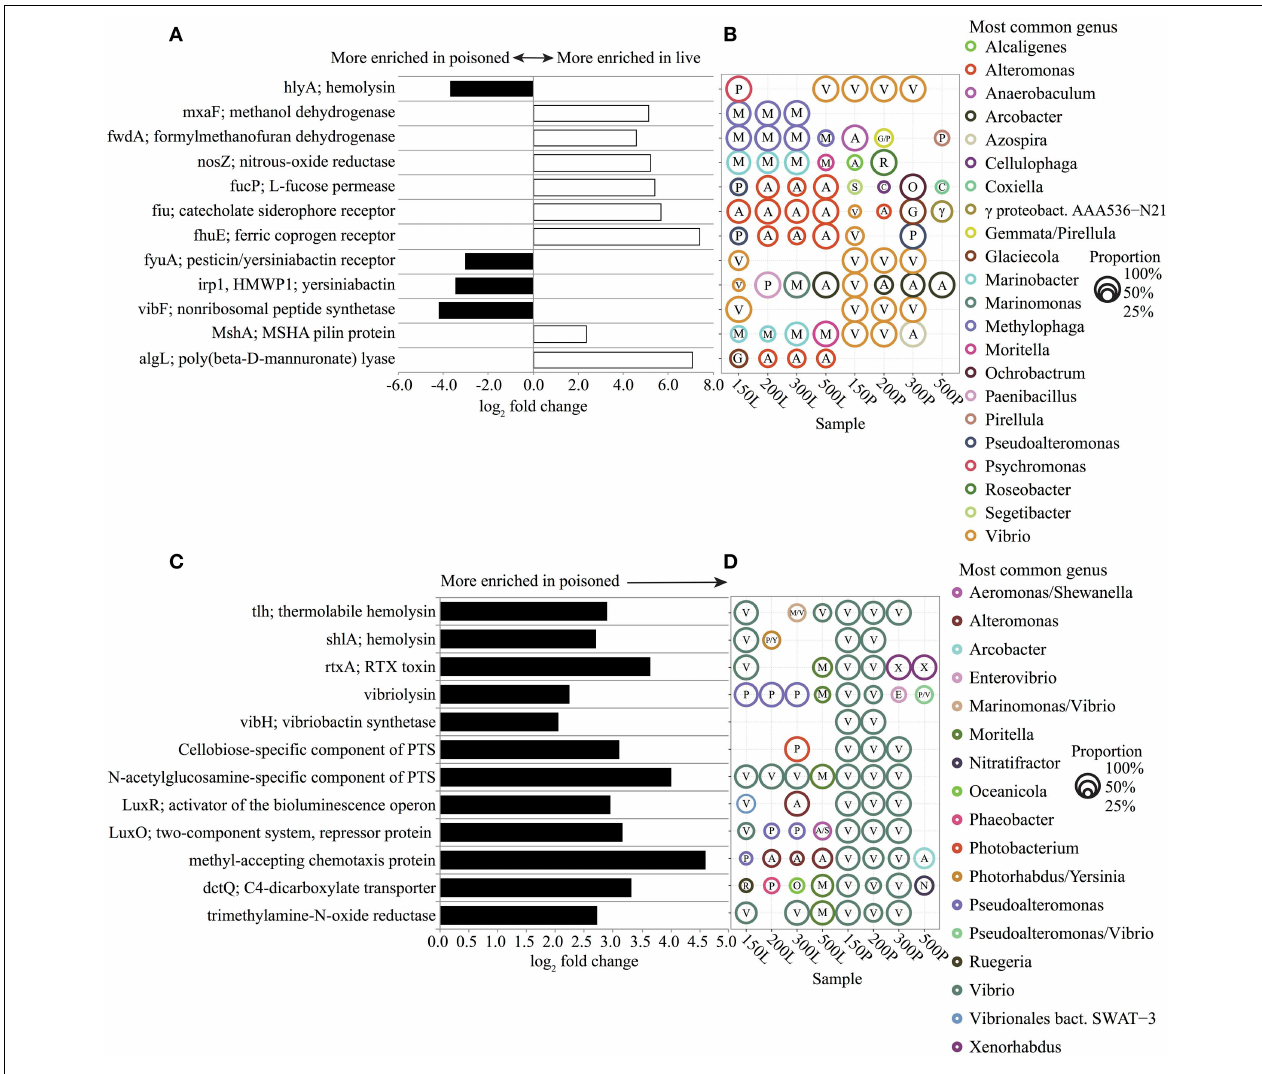
representation within live (L) and poisoned (P) sediment traps at 150, 200, 300 and 500 meter depths (B,D) . The first letter of each genus name is listed within each circle. The circle area represents the proportional representation of each genus within the specified sample. In cases where two genera each represented 50% of the sequences, both are